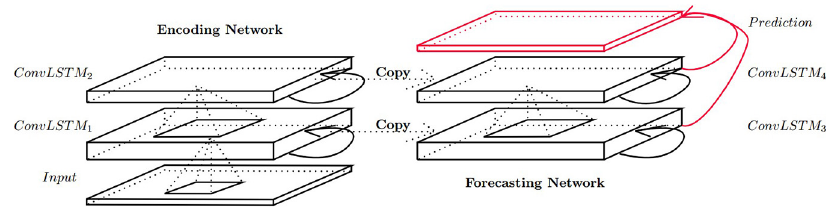
Fig. 3. The ConvLSTM encoding-forecasting model that was used in the paper in the context of frame prediction and precipitation nowcasting. [10]